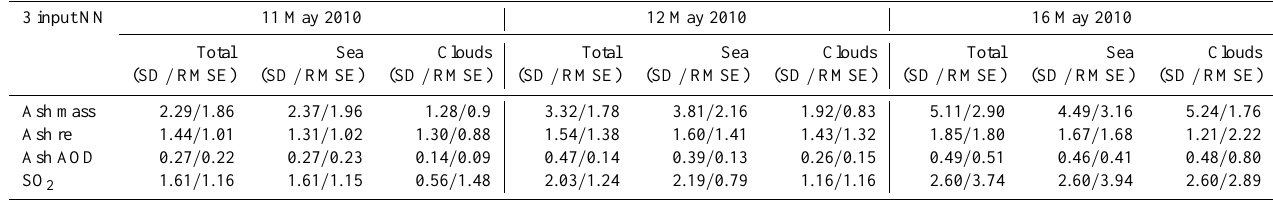
Table 6. RMSE values related to ash parameters and SO 2 for the independent validation sets. The inputs for the ash parameters are the MODIS channels 28, 31 and 32, while for the SO 2 , the MODIS channels 29, 31 and 32.